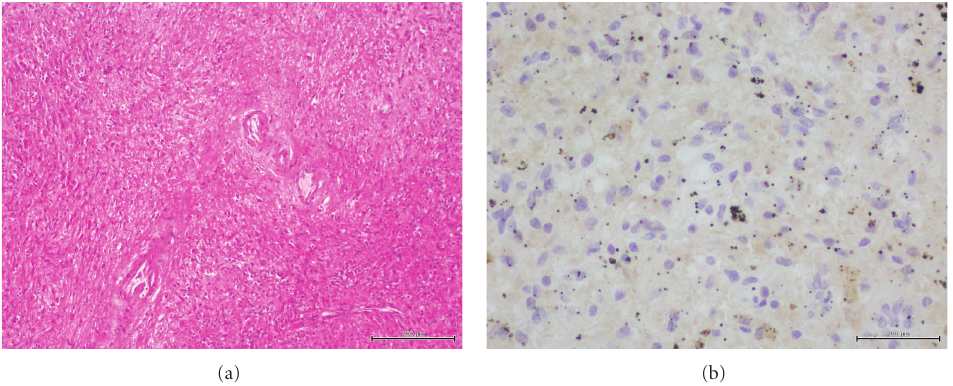
Figure 2: Splenic biopsy demonstrated the lack of lymphocytes (a). This is confirmed by the negative staining of CD79a (b), showing no residual B-cell population after rituximab.